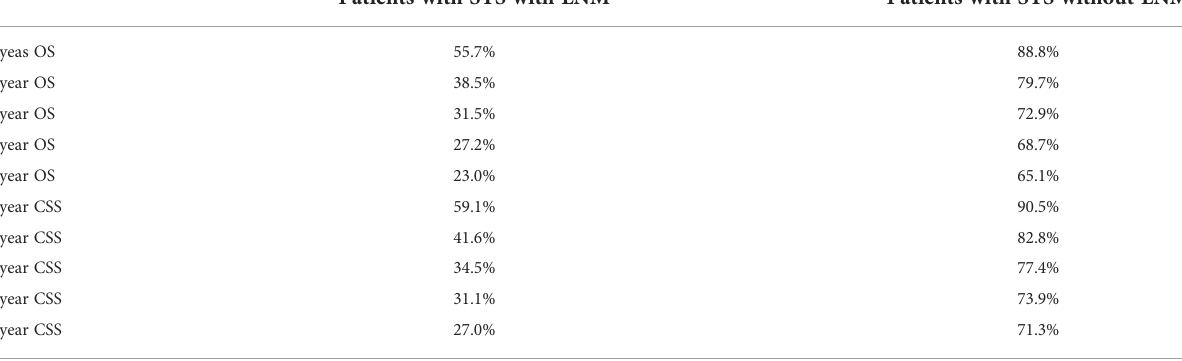
TABLE 2 Overall survival and cancer-speci fi c survival within 5 years in patients with STS with and without LNM. Patients with STS with LNM Patients with STS without